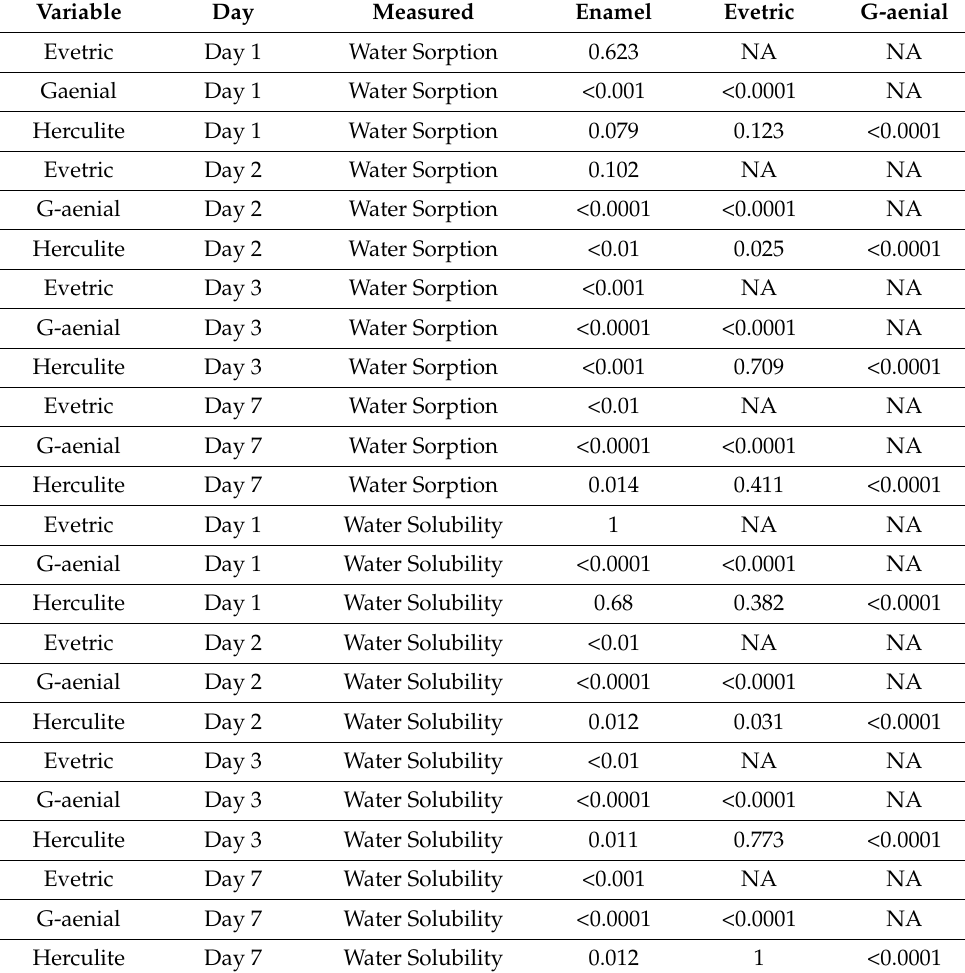
Table 3. Pairwise comparison between materials in each day. NA = not applicable.